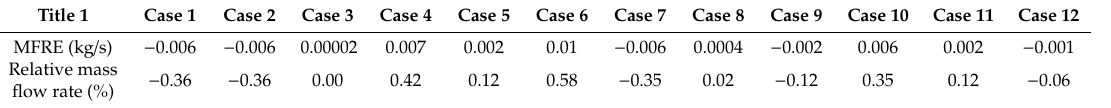
Table 2. MFRE values under di ff erent cases in steady